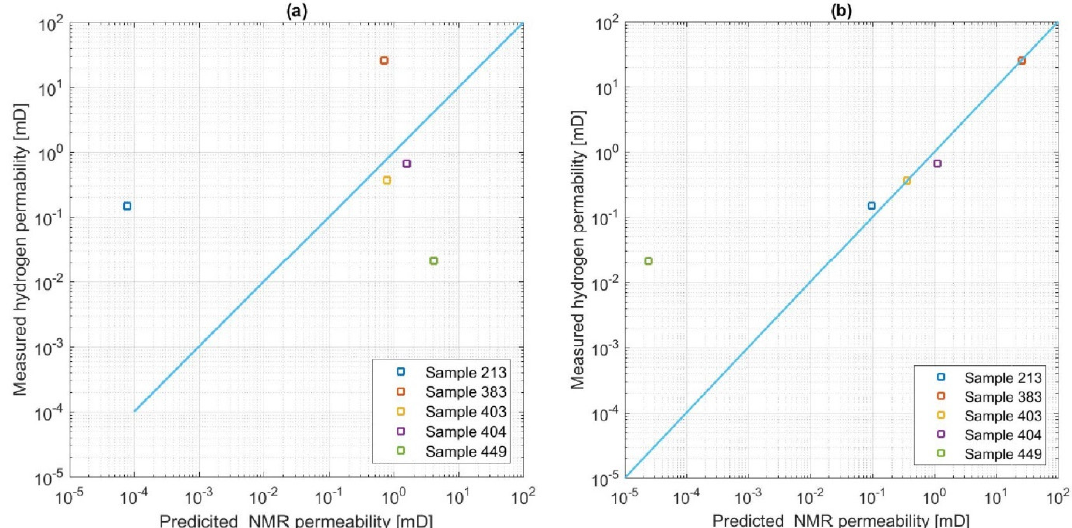
Figure 16. NMR derived permeabilities. In ( a ) the complete NMR signals were used to predict the permeabilities using equation 6. In ( b ) the permeabilities were predicted from the NMR signal using a cut–o ff value of 0.85 s.